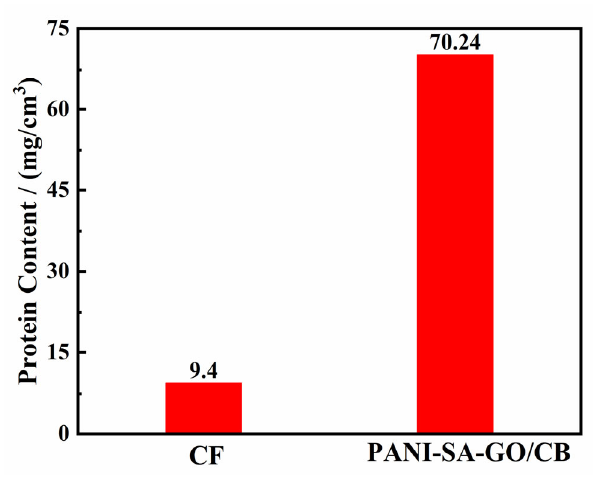
Figure 6. Protein content of MFC with two anodes.